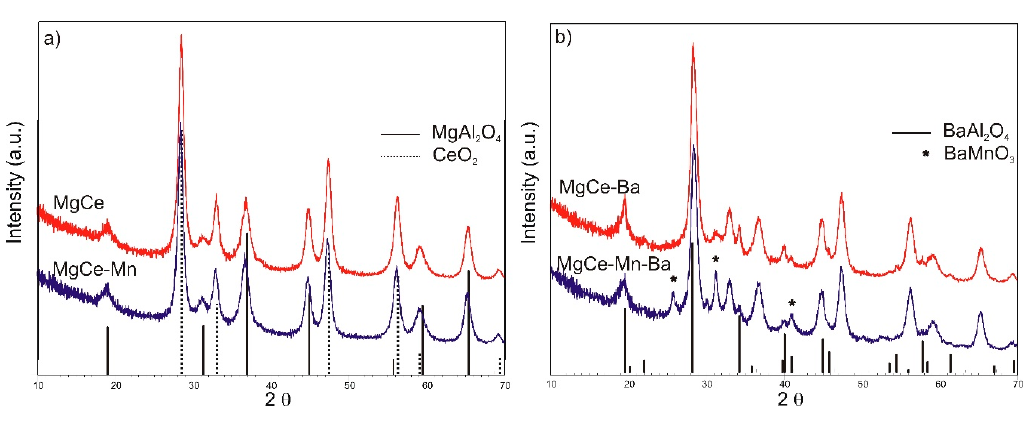
Figure 1. Powder X-ray diffraction (XRD) patterns of ( a ) MgCe and MgCe-Mn ( b ) MgCe-Ba and MgCe-Mn-Ba with simulated reflection positions of MgAl 2 O 4 , CeO 2 , BaAl 2 O 4 and BaMnO 3 . For better clarity, the reflections of MgAl 2 O 4 and CeO 2 are not marked in ( b ).